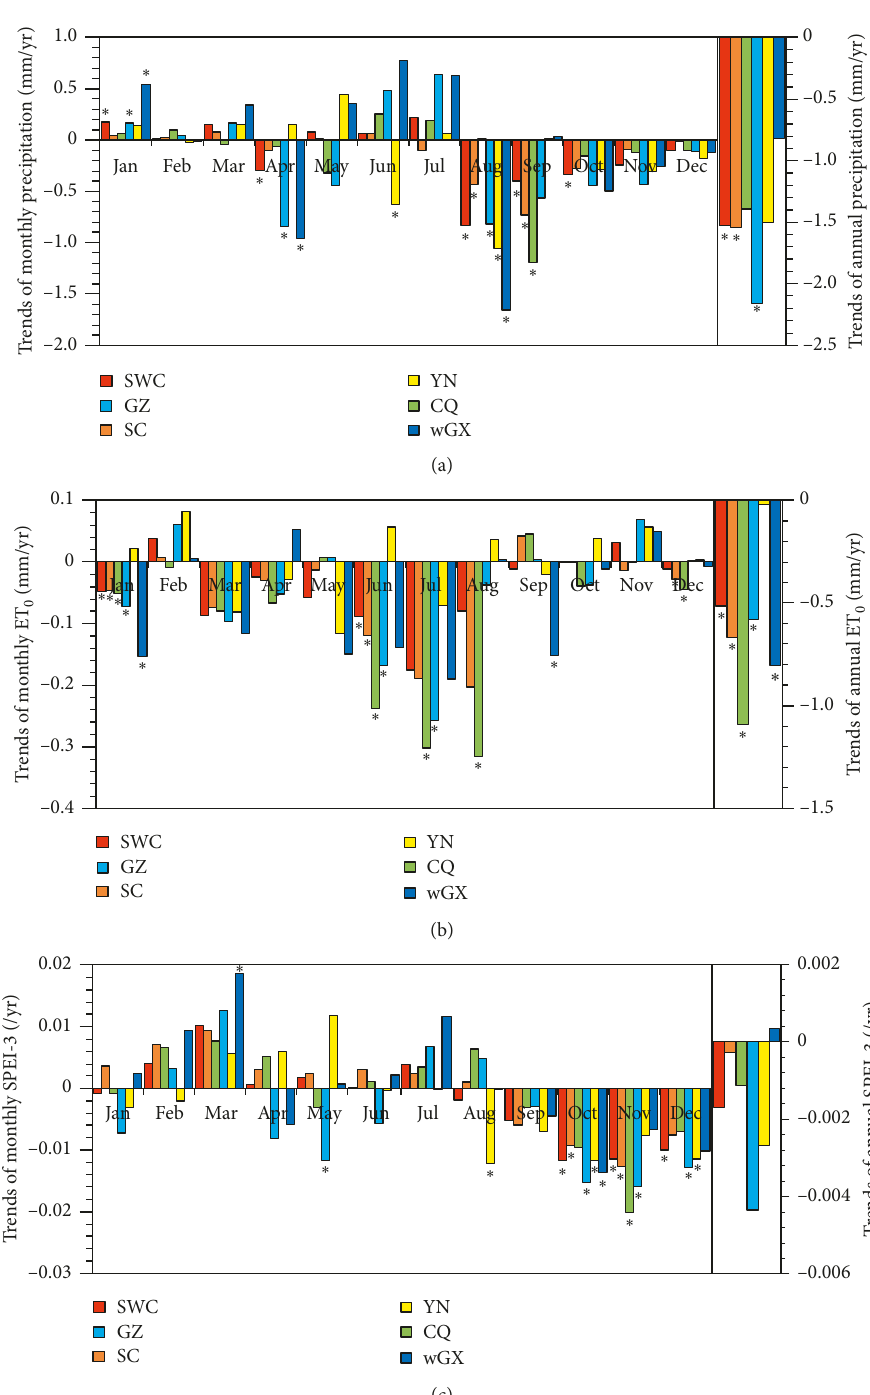
Figure 2: Monthly and annual trends of regional mean precipitation, ET